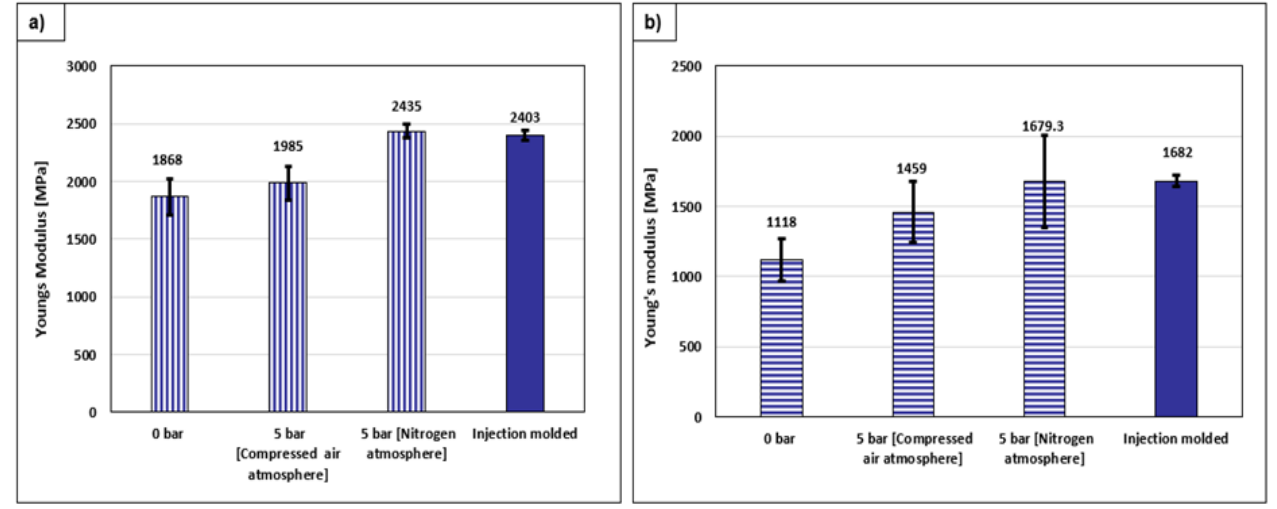
Figure 4. Samples printed under various pressure conditions were compared by Young ’ s modulus longitudinally ( a ) and transversely ( b ), with the direction of printing.